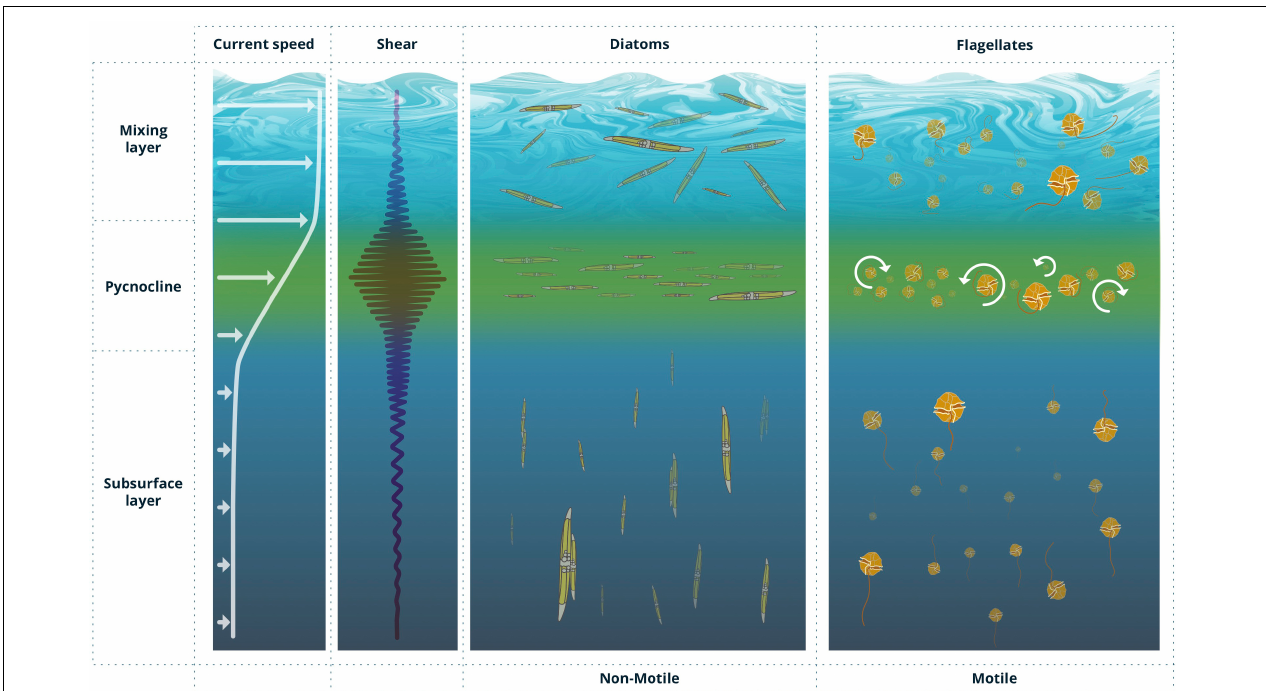
FIGURE 2 | Idealized profiles of current speed and shear in the ocean and corresponding preferential cell orientation of non-motile and motile phytoplankton cells, including the formation of thin layers, in response to varying shear